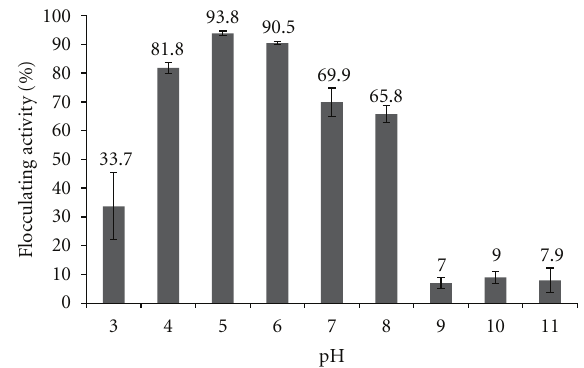
Table 1: Statistical analysis for flocculating activity with di ff erent cation treatments added with UPMB13 bioflocculant.